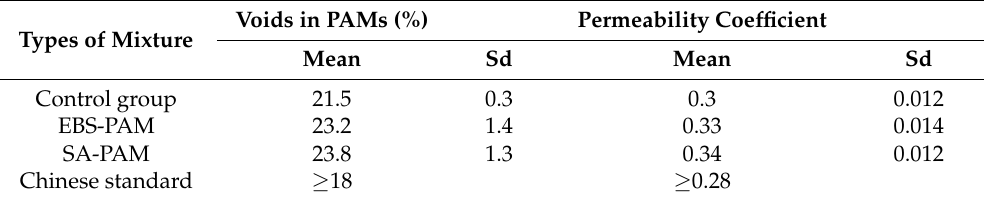
Table 4. Void characteristics and permeability coefficient. PAM: porous asphalt mixture.